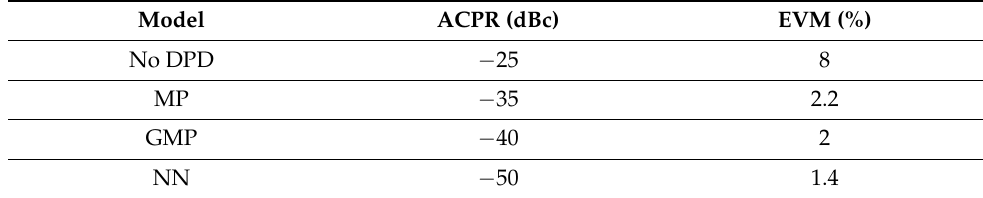
Figure 9. Spectral regrowth for output with DPD-NN, DPD-GMP and without DPD. Table 3. Comparison among DPD methods for 0 dBm input